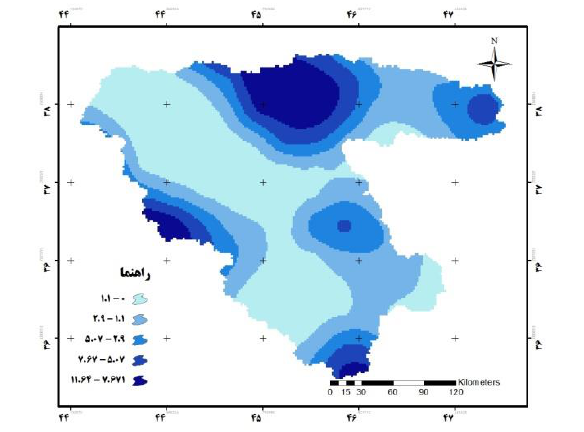
Figure 20: Interpolation of TRMM precipitation data over the catchment basin of Urmia lake (April 23 rd